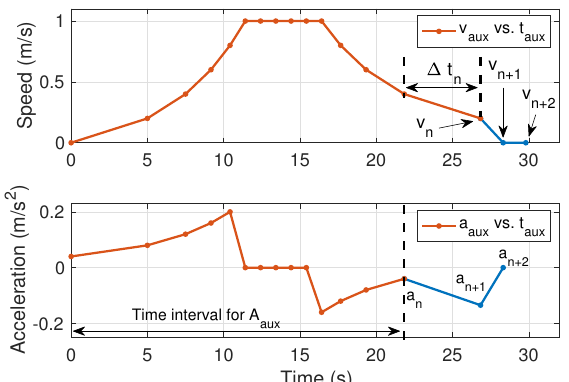
Figure 5. Concept illustration of the calculation of ∆ t when v g ( i ) = 0 m/s to guarantee that the train